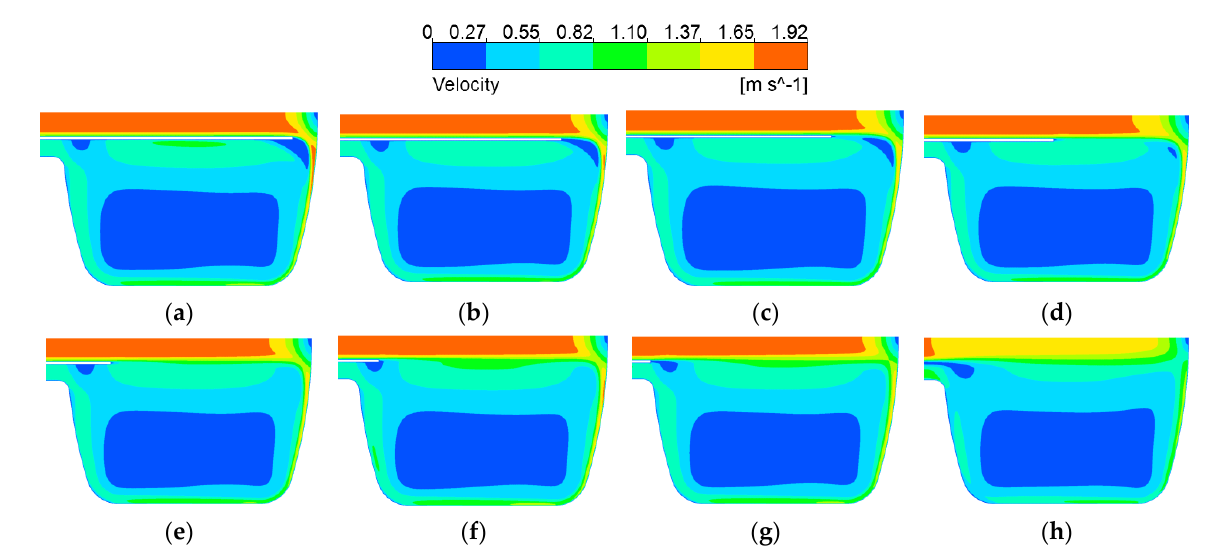
Figure 9. Velocity distribution in CHM: ( a ) H/D = 0.5; ( b ) H/D = 1; ( c ) H/D = 1.5; ( d ) H/D = 3; ( e ) H/D = 4.5; ( f ) H/D = 5; ( g ) H/D = 5.5; ( h ) H/D = 6.